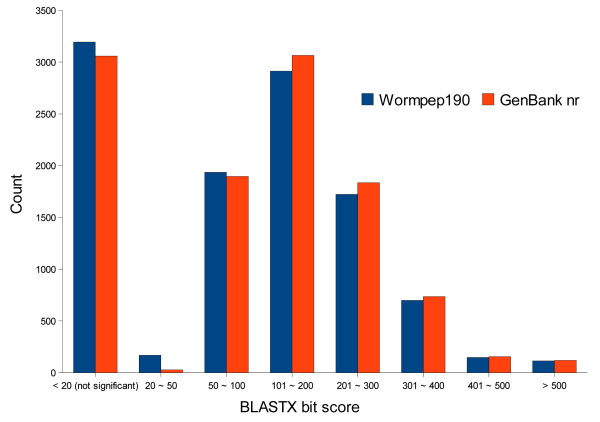
Distribution of bit scores from the best matches of BLASTx searches of H. bacteriophora distinct ESTs. BLASTx searches with bit scores less than 20 were not significant, roughly corresponding to E value > 1e-5.